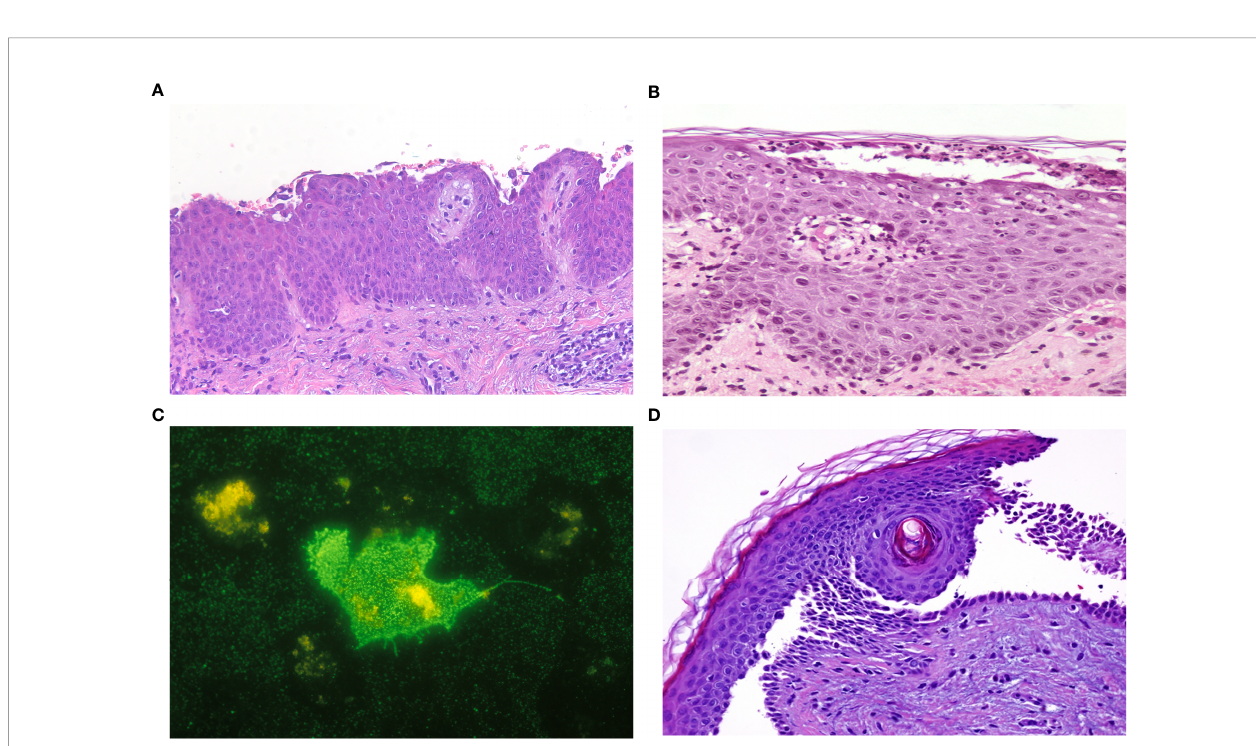
FIGURE 2 | Histopathological features. (A) A 33-year-old woman with exclusively anti-Dsc1 IgG antibodies with complete detachment at the subcorneal layer, acantholytic cells and moderate lymphoplasmacytic perivascular dermal in fi ltrate (Hematoxylin – Eosin stain, x200). (B, C) A 66-year-old man with exclusively anti-Dsc1 IgA antibodies with a subcorneal neutrophilic pustule with dermal lymphocytic in fi ltrate (Hematoxylin – Eosin stain, x200) and a positive IgA indirect immuno fl uorescence with COS7 cells transfected with desmocollin 1 protein. (D) A 70-year-old man with both anti-desmocollin 2,3, and anti-desmoglein 1,3 antibodies and suprabasal acantholysis with dermal neutrophilic in fi ltrate (Hematoxylin – Eosin stain, x200).